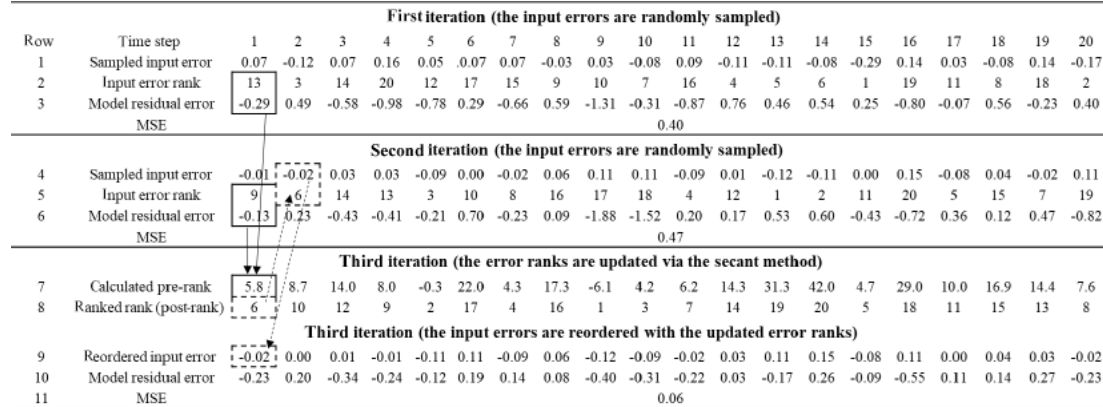
Table A1. An example illustrating the BEAR method.